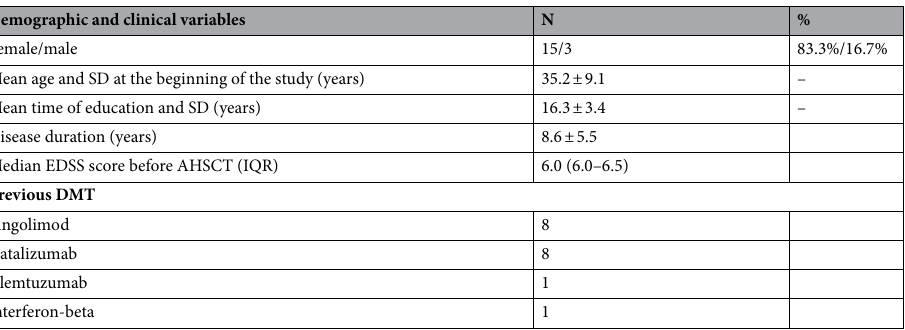
Table 1. Numerical and percentage distribution of patients with MS undergoing AHSCT, according to demographic and clinical characteristics. AHSCT Autologous Haematopoietic Stem Cell